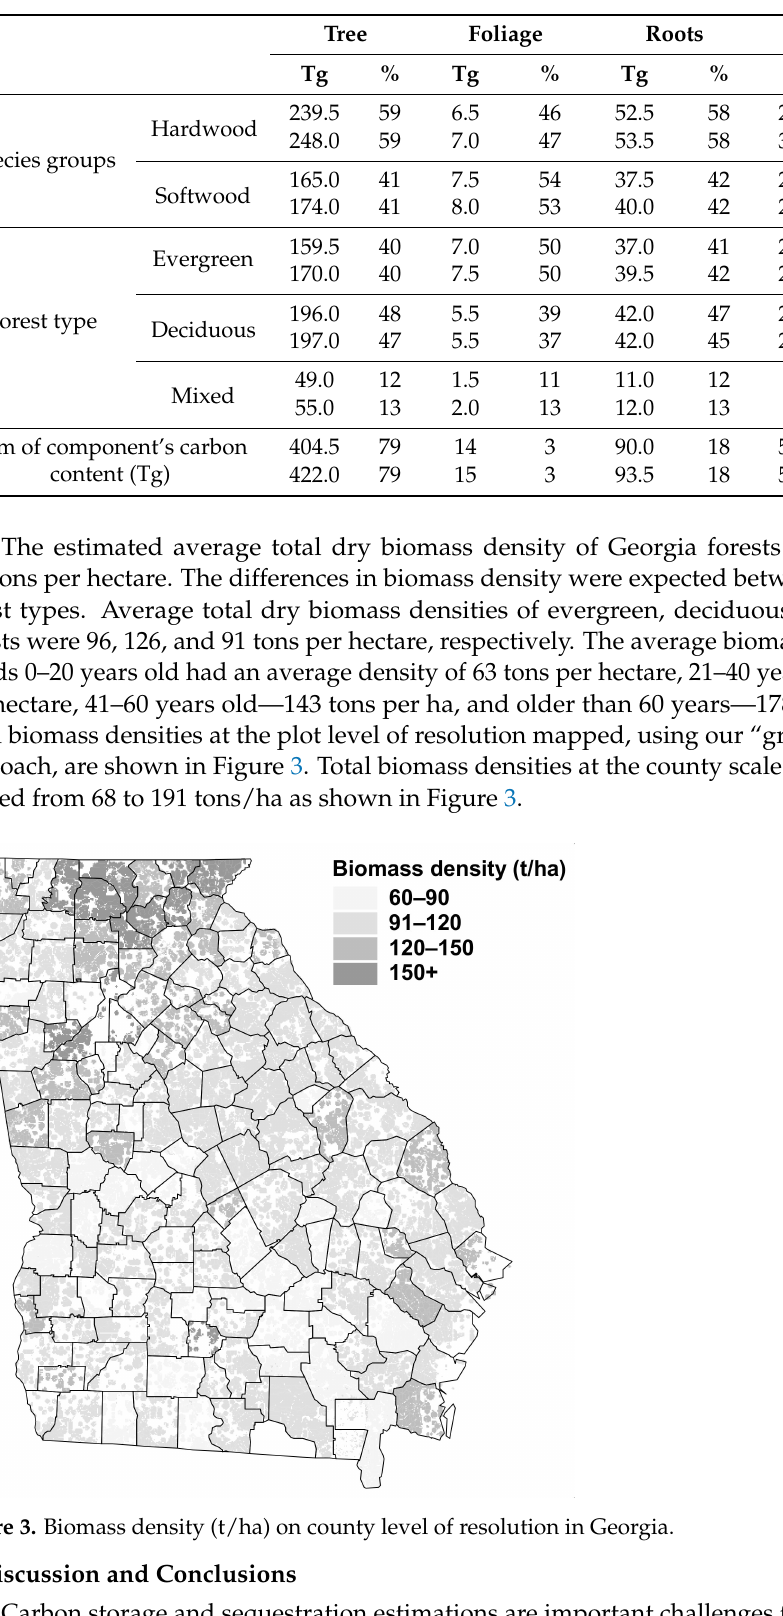
Table 3. Carbon pools of Georgia’s forests (1989/1997).